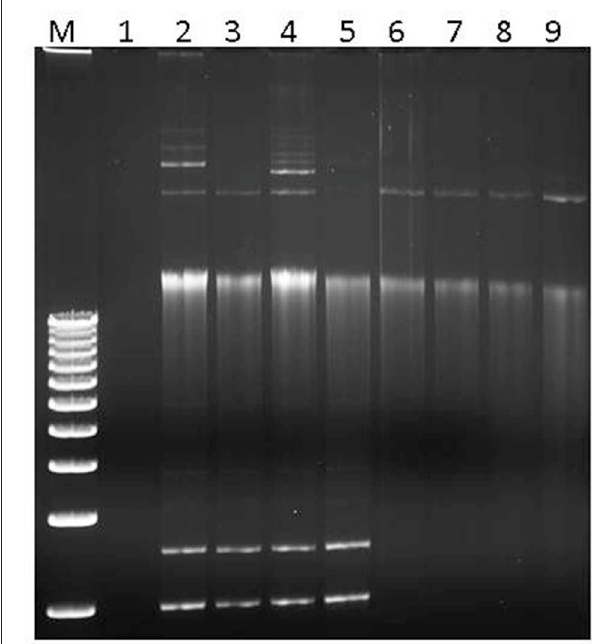
FIGURE 1 | Plasmid separation profiles of the donor S. flexneri isolates, naïve E. coli recipient strain, and E. coli transformants. Lane 1: naïve E. coli Top10 recipient. Lanes 2–5: S. flexneri isolates 06-3102, 06-2384, 06-2835, 06-2836. Lanes 6–9: E. coli transformants t-06-3102, t-06-2384, t-06-2835, t-06-2836. Similar results were obtained for the transconjugants (not